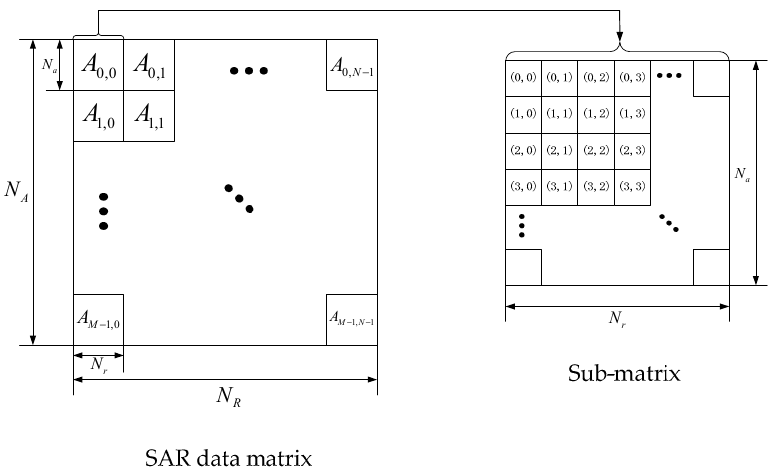
Figure 6. Schematic diagram of matrix block.